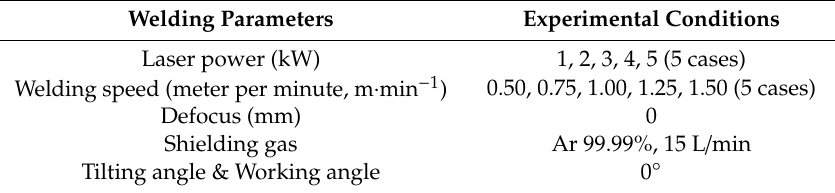
Table 3. Experimental conditions of laser bead on plate (BOP).